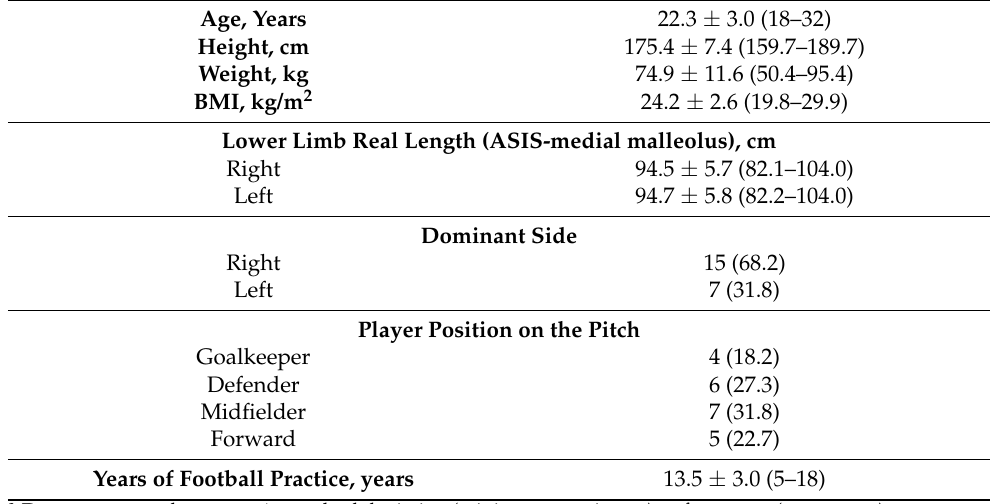
Table 1. Sample characterization data ( n = 22) a .